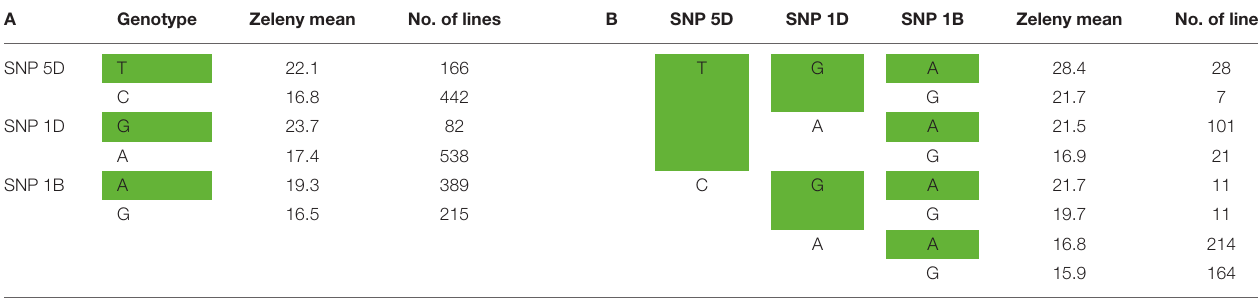
TABLE 5 | Mean values for Zeleny sedimentation and number of lines with the different alleles of the top SNPs on chromosome 5D, 1D, and 1B. A